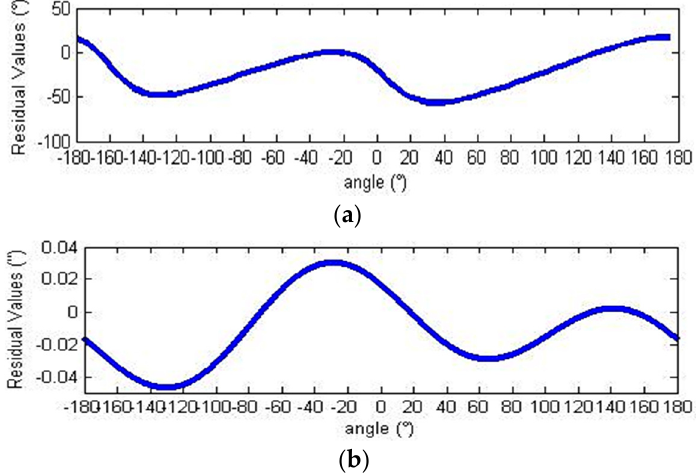
Figure 12. Demodulation errors. ( a ) Demodulation error before calibration; ( b ) demodulation error after calibration.